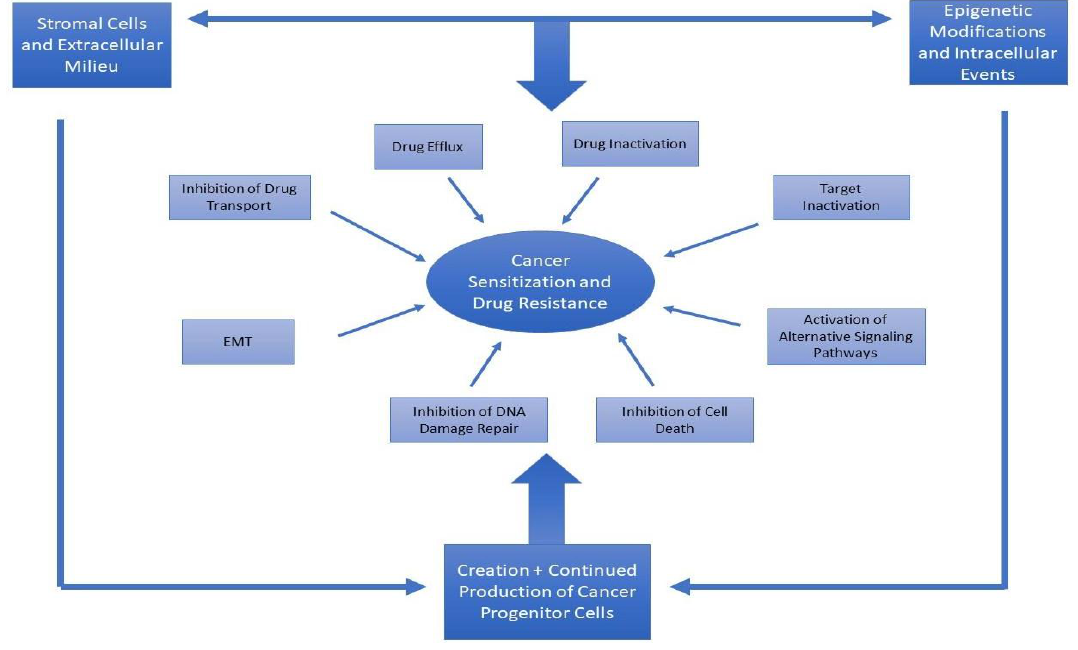
Figure 1. This figure demonstrates a model of possible causes of cancer drug resistance. All of these pathways could be regulated by extracellular signaling, epigenetic events, and intracellular events and signaling. A combination of all these elements produces cancer progenitor cells and sustains their production, even when cancer is apparently in